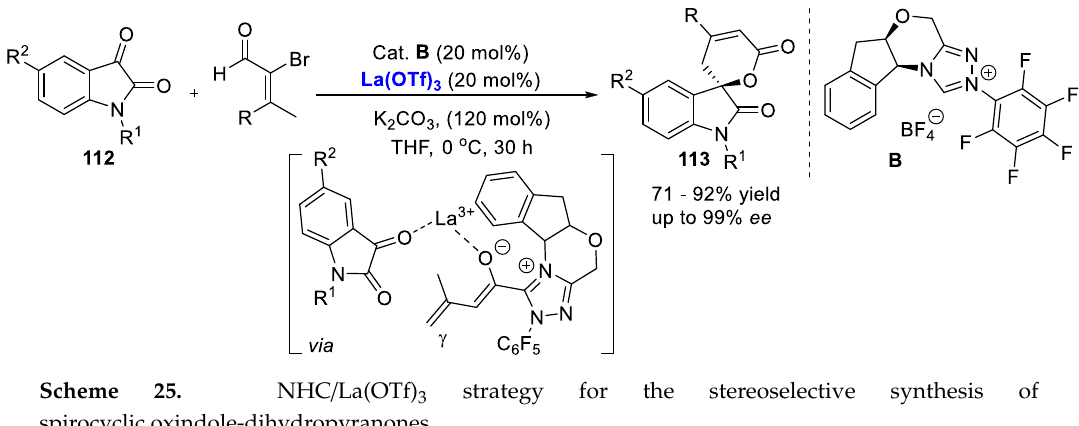
oxindole-dihydropyranones. spirocyclic